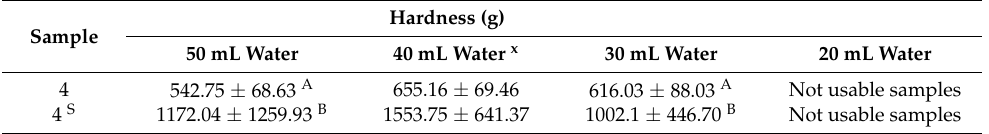
Table 4. The influence of water addition on biodegradable spoon texture.